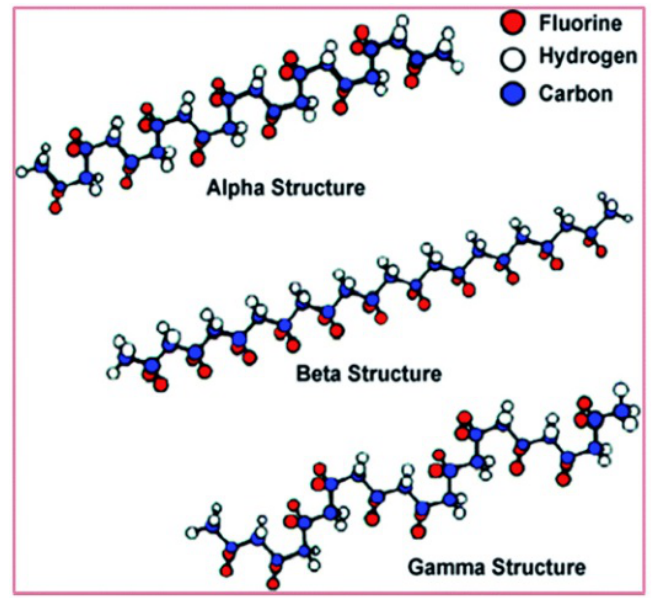
Figure 1. Diagrams of the chain conformation for α, β and γ crystalline phase s of PVDF [13].